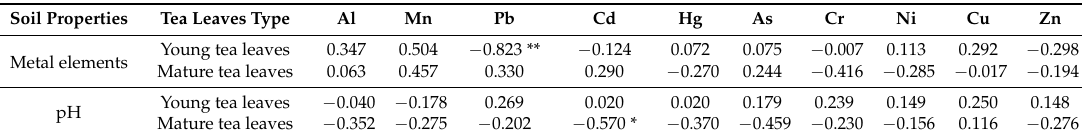
Table 4. Pearson’s correlation between metal elements in tea leaves and soil physico-chemical properties ( n =